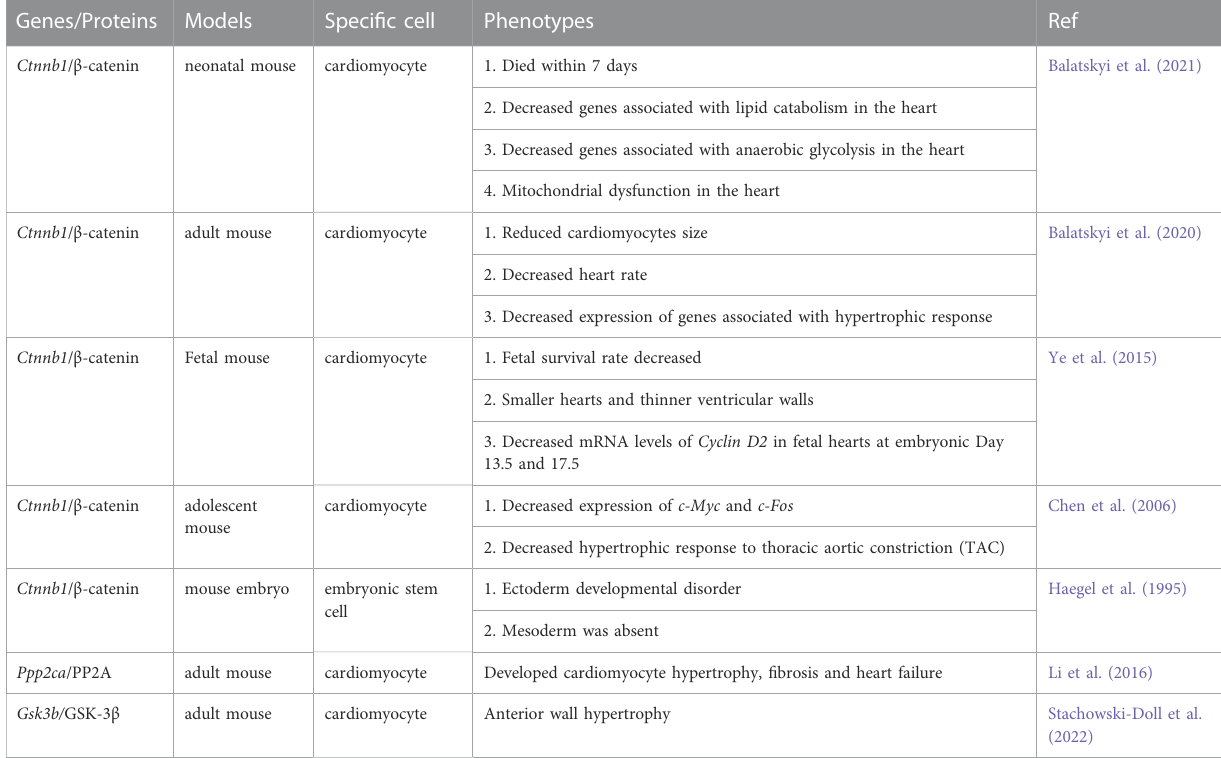
TABLE 1 Sevaral phenotypes associated with cardiac development and function caused by Wnt/ β -catenin pathway-related genomic